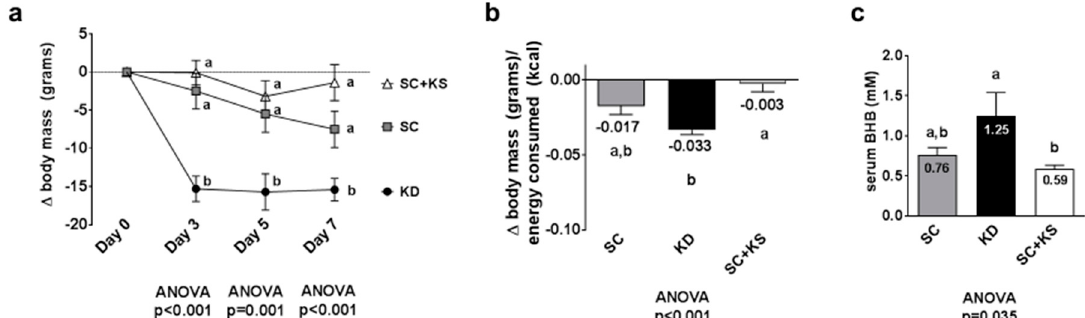
Figure 1. Change in body mass, overall feed efficiency and serum beta-hydroxybutyrate (BHB) levels in 1 week-fed rats. Legend: Change in body mass is presented in panel ( a ). Feed efficiency is presented in panel ( b ). Serum BHB levels are presented in panel ( c ). Data in panel ( a ) are presented as mean ± standard error values ( n = 10 per group). In panels ( b , c ), all bars are presented as mean ± standard error values and group means are indicated within each bar. For all panels, ANOVA p -values are presented below data, and different lettering (“a” versus “b”) indicates significant between-group differences whereas shared lettering (“a” as well as “b” or “a, b”) indicates lack of significant between-group differences. Abbreviations: SC, standard chow-fed rats; KD, ketogenic diet-fed rats; SC + KS, standard chow-fed rats with supplemental sodium beta-hydroxybutyrate.